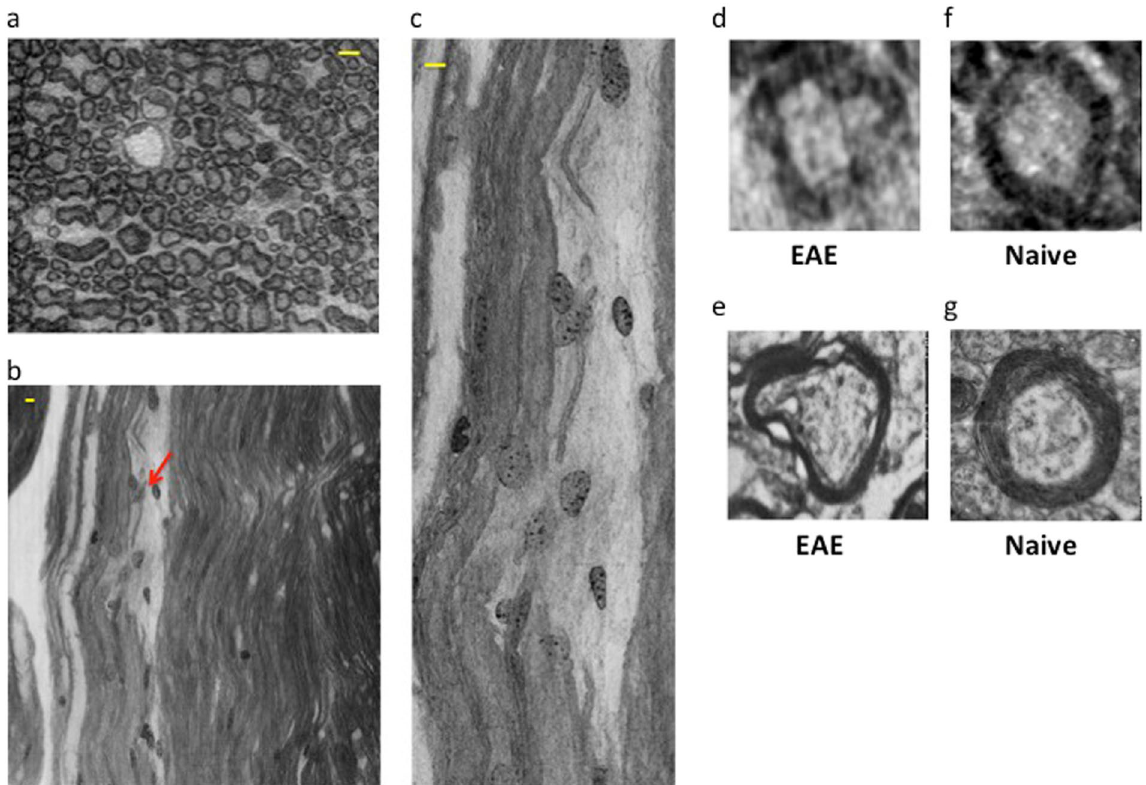
Figure 8. Nano-XPCT of myelin damage in EAE. ( a , b ) Show the axial and longitudinal views of the white-grey matter interface in the spinal cord of EAE-affected mouse sample (5 dpo). Osmium-stained myelin (black) can be seen around axon fibers. ( c ) is a magnification of b in the region where invading cells can be seen associated with damaged myelin. d-g show the axial views of a myelinated axon by XPCT (upper panels) and TEM (lower panels) in EAE-affected ( d , e ) and naïve ( f , g ) samples. Scale bars 8 μ m. The pixel size of the nano-XPCT is 130 nm (spatial resolution ~260